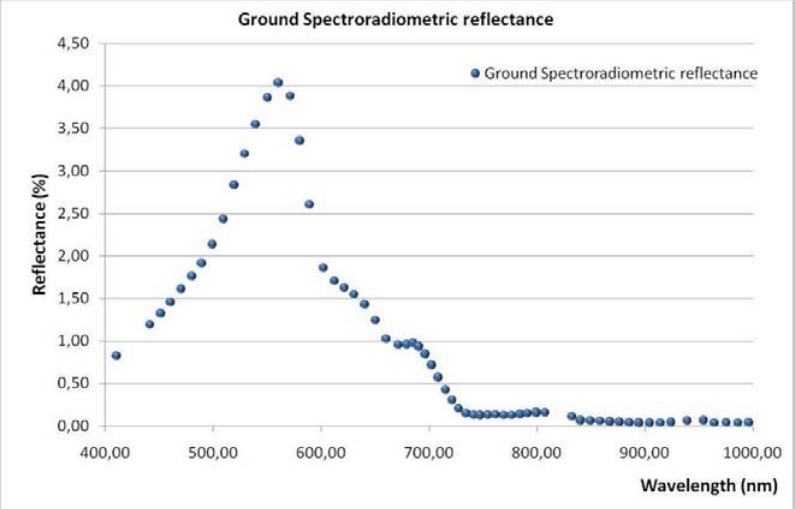
Figure 3. Typical ground spectroradiometric measurements at the Asprokremmos